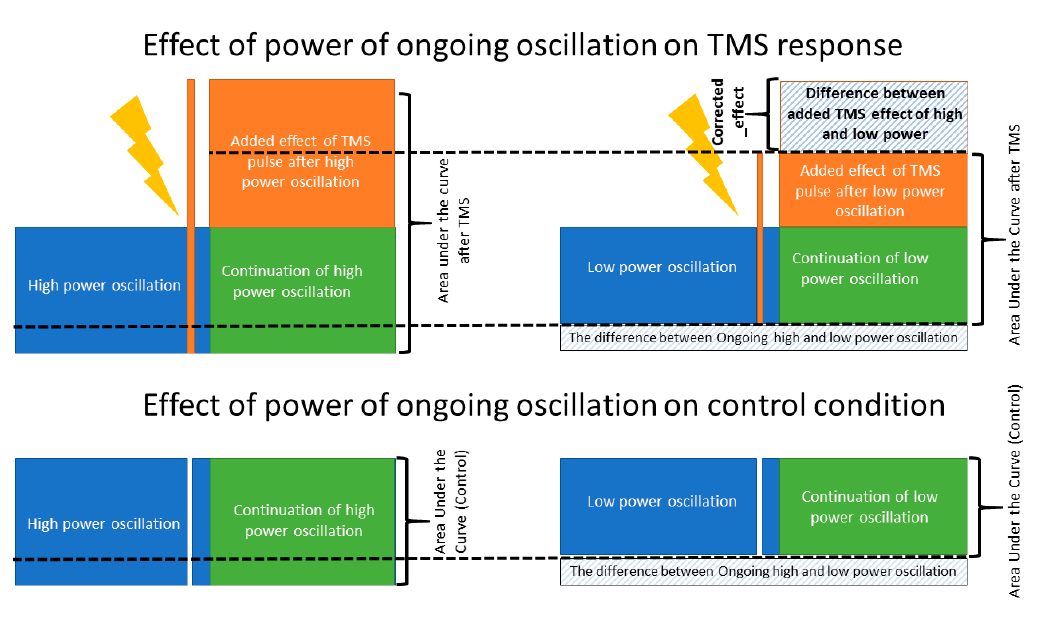
Figure 4. Corrected_effect . A schematic figure, illustrating the effect of ongoing brain oscillation on the post stimuli area under the curve and the added evoked response of TMS to the amplitude of ongoing low- and high-power oscillations. The corrected_effect , calculated based on Equation (3), illustrates the isolated effect of TMS pulse when the effect of ongoing brain oscillation is removed. The corrected_effect was significantly larger than zero only in the theta and beta bands ( p < 0.01).